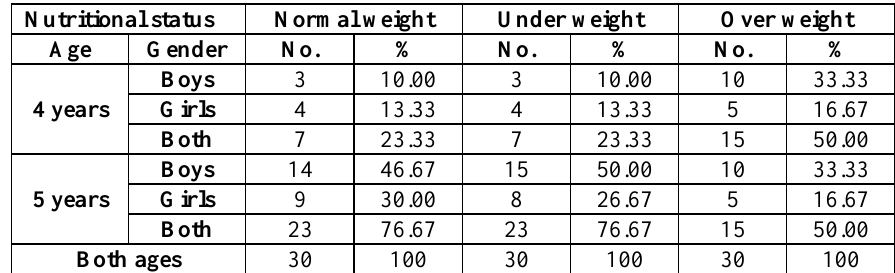
Table 2: Distribution of Sample According to Nutritional Status (in Number and Percentage of Each Group) Described by Age and Gender